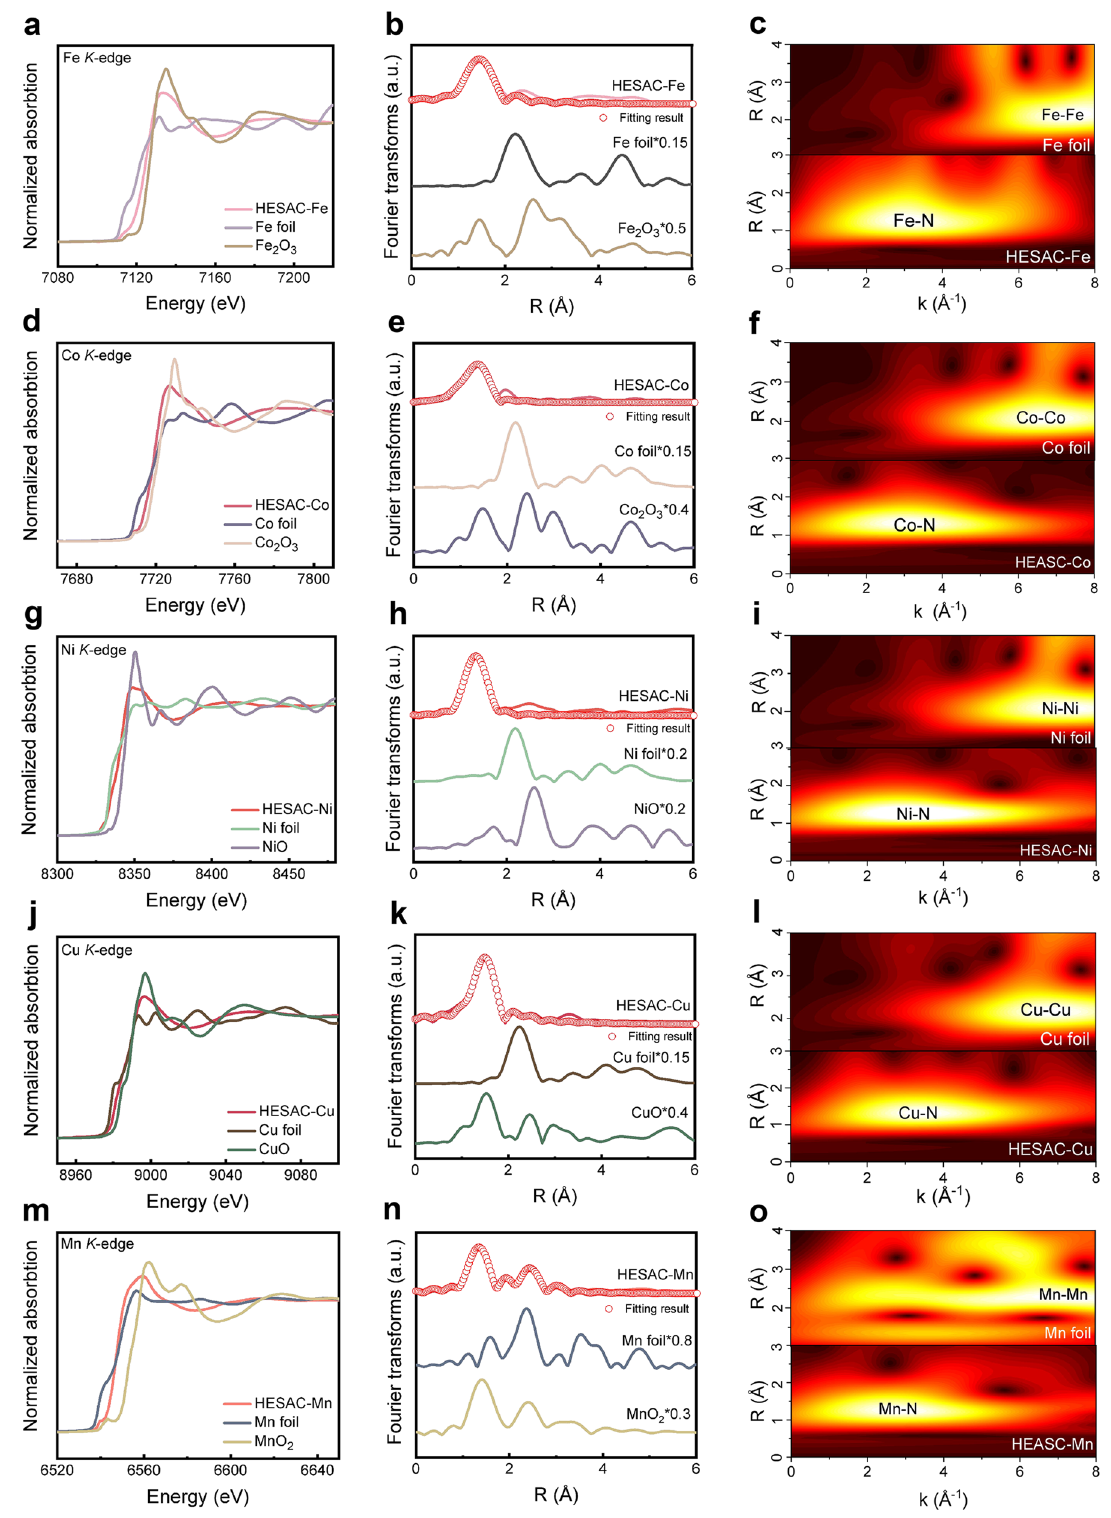
Fig.2|XANESandEXAFSdataofpreparedquinaryHESACs(FeCoNiCuMn).a,d, g, j, m XANES spectra ( b, e, h, k, n ) of the Fe K -edge, Co K -edge, Ni K -edge, Cu K -